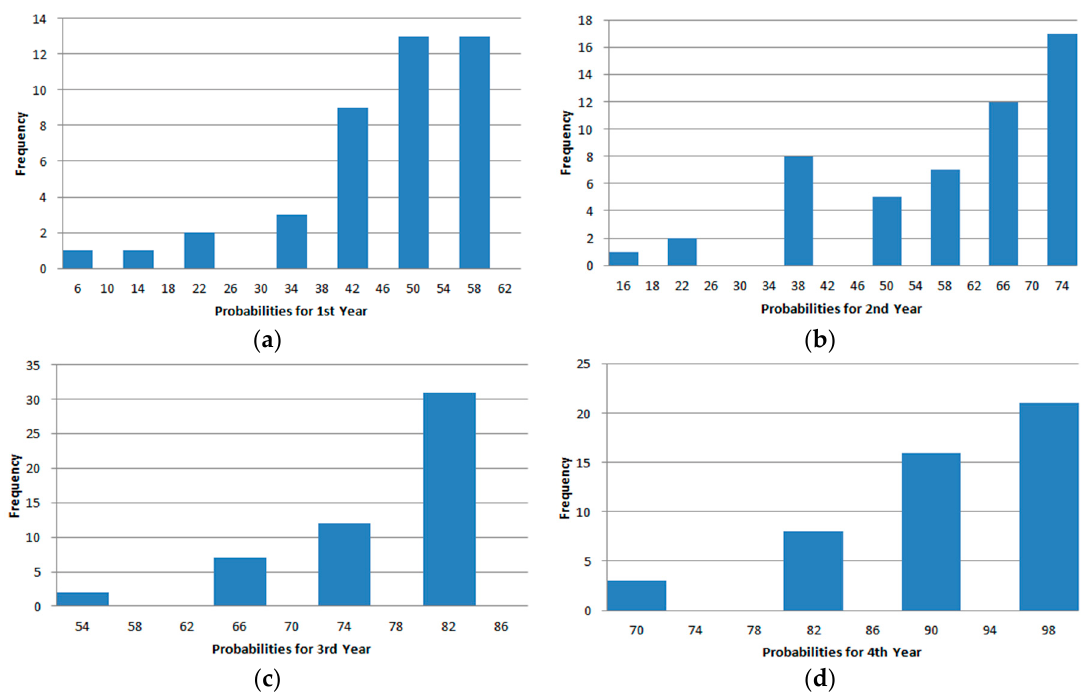
Figure 3. Illustrations resulting to the binning of the probabilities: ( a ) probabilities of ICT fluency for the 1st year; ( b ) probabilities of ICT fluency for the 2nd year; ( c ) probabilities of ICT fluency for the 3rd year; and ( d ) probabilities of ICT fluency for the 4th year.